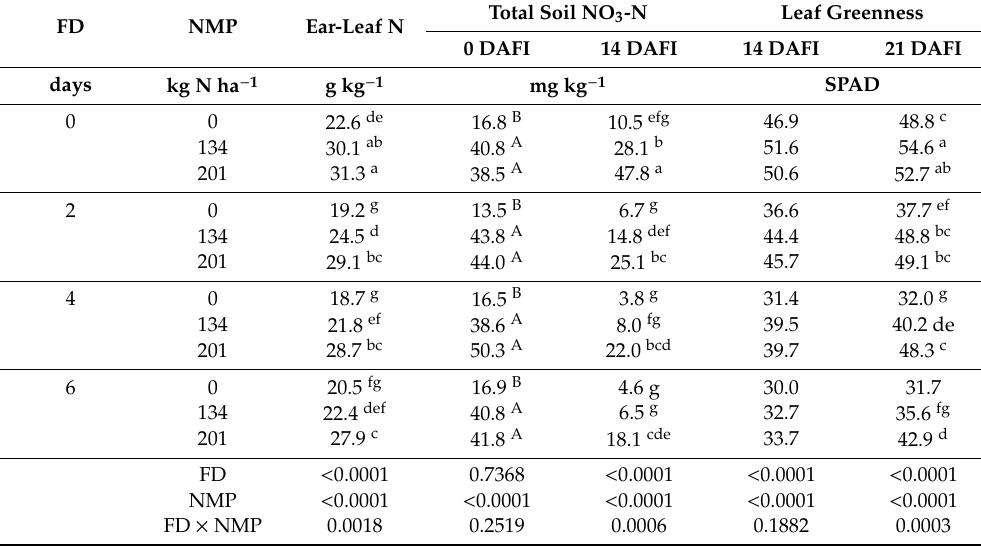
Table 6. Interaction of flood duration (FD) and nitrogen application (NMP) for ear-leaf N concentration at R1, total soil nitrate-nitrogen (NO 3 -N) concentration 0 and 14 days after flood initiation (DAFI), and leaf greenness from 14 and 21 DAFI in 2018. p values are presented within each column for FD, NMP, and FD × NMP. When present, di ff erent lowercase letters indicate di ff erences in means within each column and FD × NMP interaction and di ff erent uppercase letters denote di ff erences in NMP. Total Soil NO 3 FD NMP Ear-Leaf N